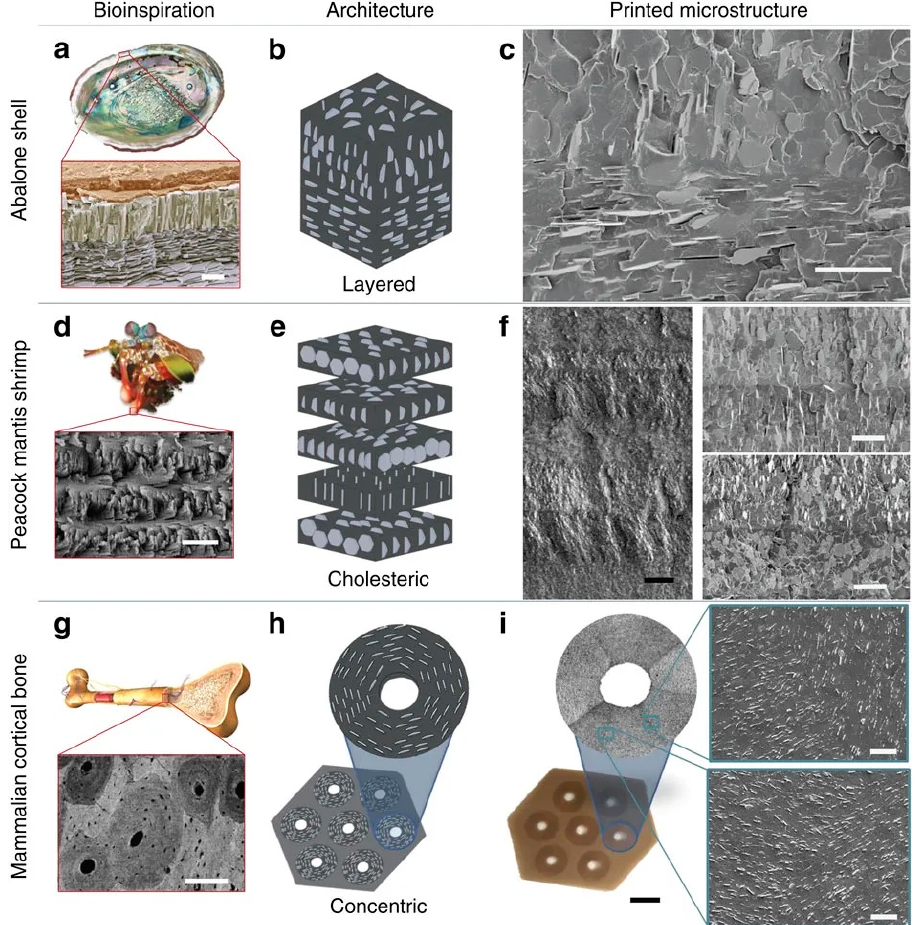
Figure 10. Bioinspired composites with microstructured architectures can be recreated with 3D magnetic printing. ( a ) The Haliotidae sp. Abalone shell exhibits a layered structure of calcite prisms topping in-plane aragonite platelets (nacre). This architecture is ( b ) simplified and ( c ) 3D magnetic printed. ( d ) The dactyl club of the peacock mantis shrimp exhibits a cholesteric architecture of mineralized chitin fibres. This architecture is ( e ) simplified and ( f ) 3D magnetic printed. ( g ) The mammalian cortical bone exhibits concentric plywood structures of lamellae-reinforced osteons. This architecture is ( h ) simplified and ( i ) 3D magnetic printed. All printed microstructures are acrylateurethane co-polymers reinforced by 15 volume percent alumina platelets. Scale bar: 5 mm in ( a ); 25 mm in ( c ); 15 mm in ( d ); 50 mm (black) and 20 mm (white) in ( f ); 200 mm in ( g ); and 5 mm (black) and 25 mm (white) in ( i ). Reprinted from [38], © 2015, with permission from Springer Nature.